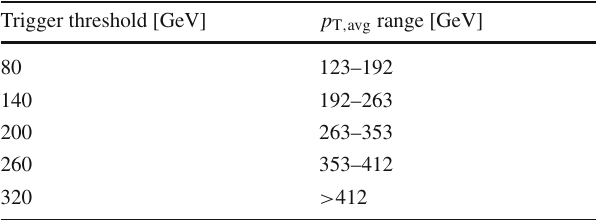
Table 1 List of single-jet trigger thresholds used in the analysis Trigger threshold